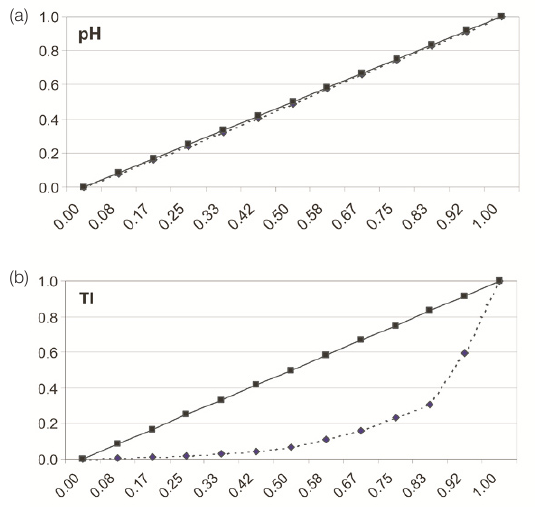
Table 6. The results of ANOVA test and the Kruskal-Wallis (K.W.*) one-way analysis of variance.